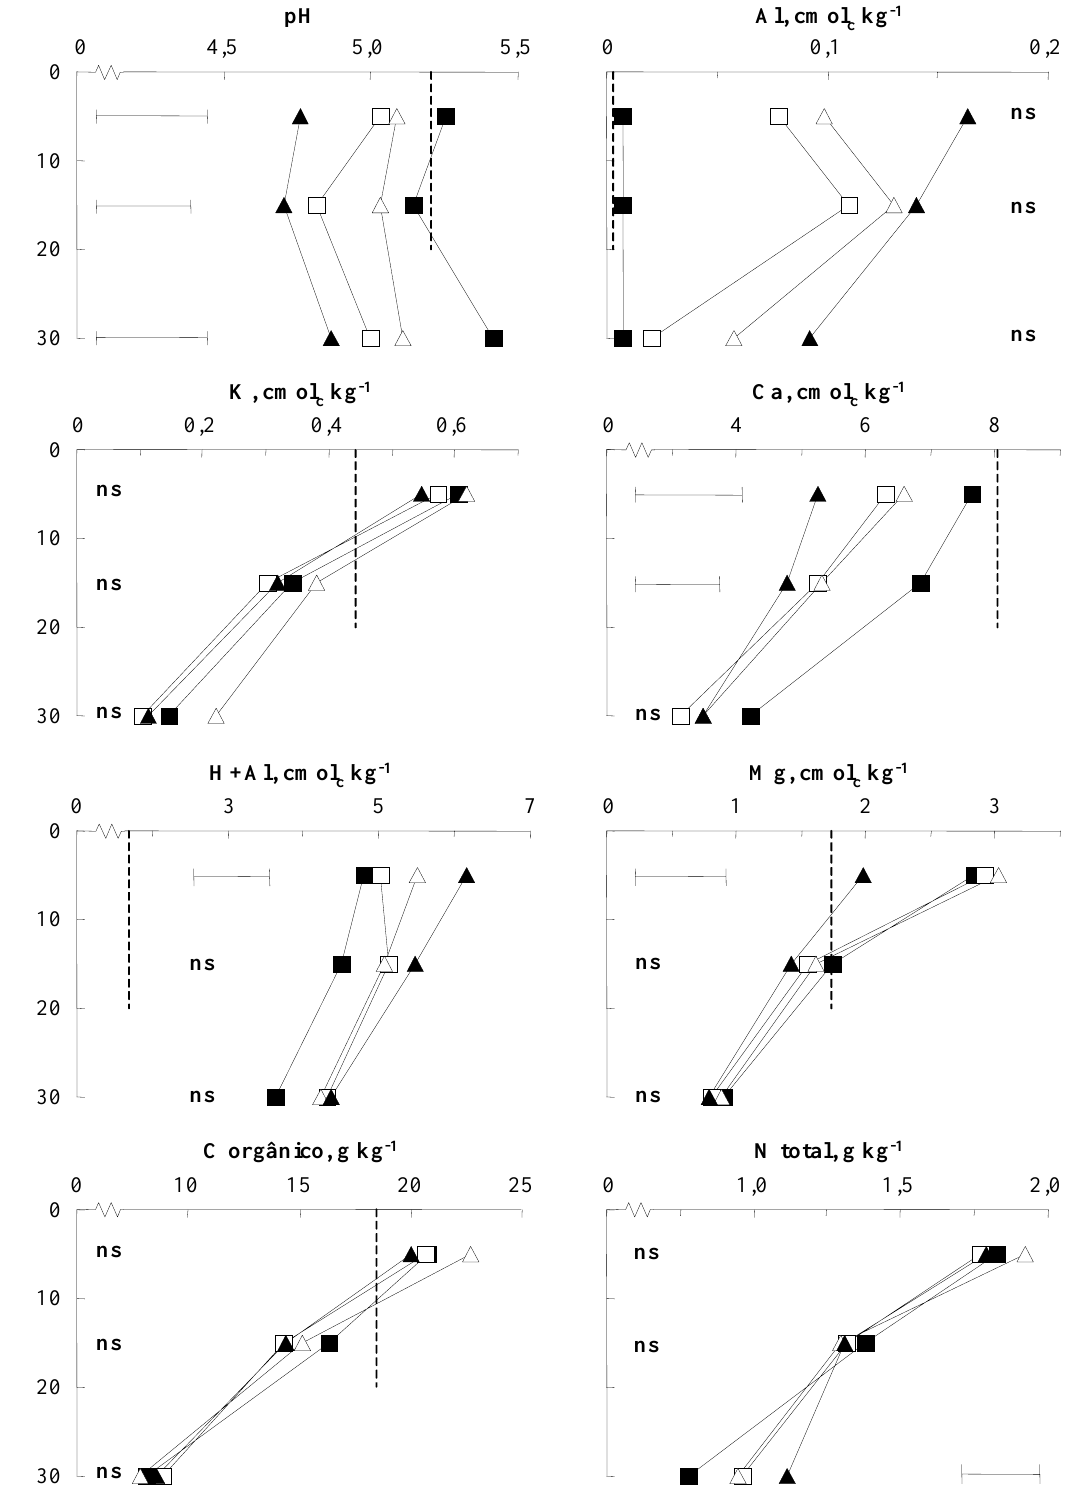
Figura 1. Características químicas do solo em Londrina. Tratamentos: TS ( ); TSA( ); TMA( D ); TM( ); Valor Inicial (0-20 cm)( --- ). A seqüência de culturas utilizadas nos sistemas encontra-se no quadro 1. Os valores iniciais não foram considerados na análise estatística. Barras horizontais representam a diferença mínima significativa indicada pelo teste